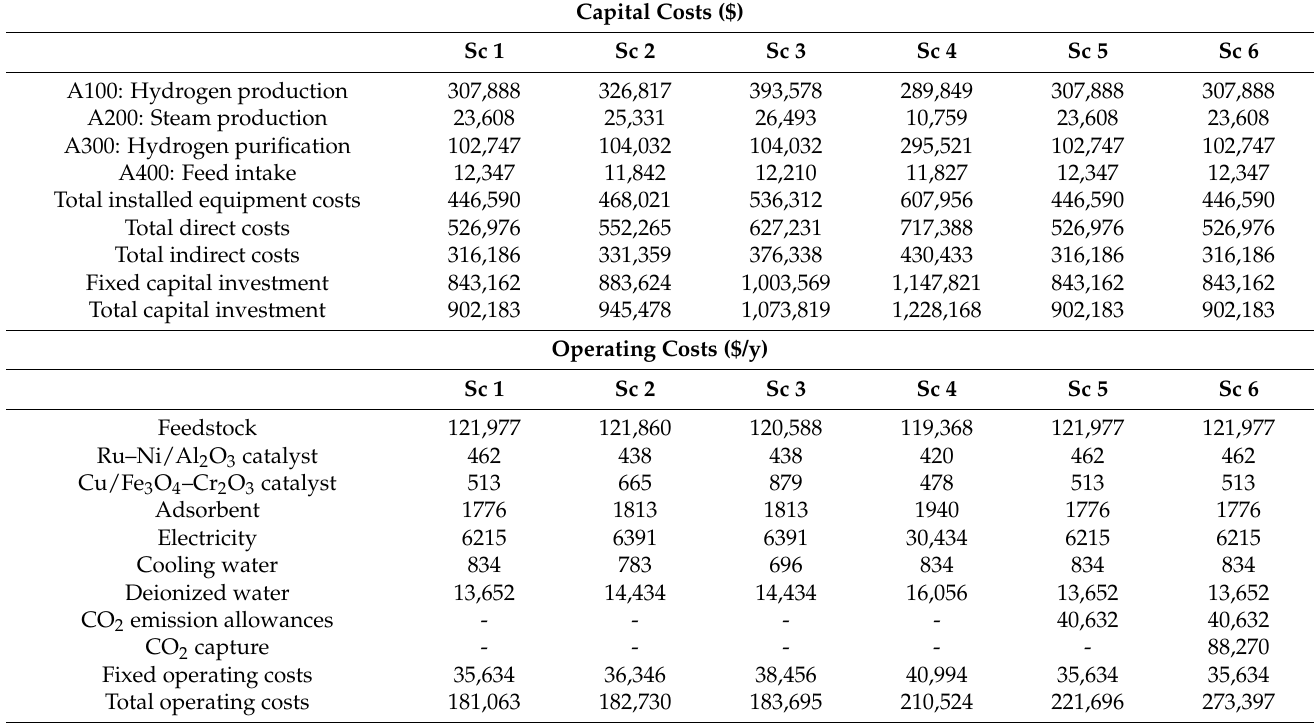
Table 4. Capital and operating costs in six